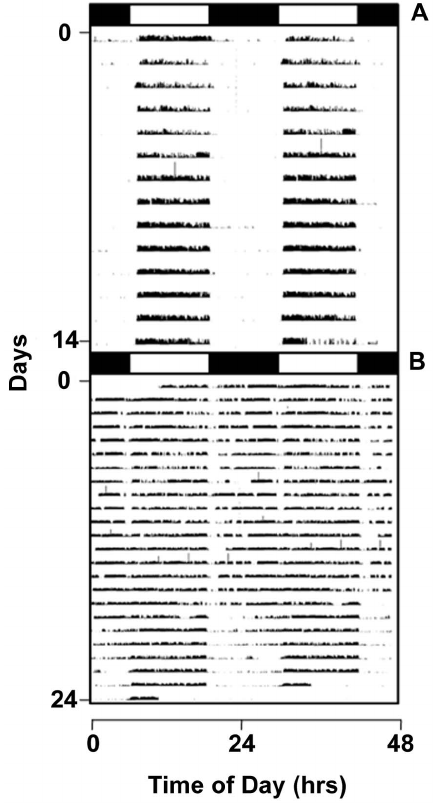
Figure 1. Locomotor activity of non-migrating and migrating white-throated sparrows. Double-plotted actograms displaying locomotor activity recorded from representative non-migrating ( A ) and migrating ( B ) white-throated sparrows under a constant 12 hr light and 12 hr dark photoperiod. White and black bars above each actogram represent hours of lights-on and lights-off, respectively. WTSP are diurnal during the non-migratory period; Zugunruhe was directly observed in migrating individuals using infrared videography during hours of lights-off.